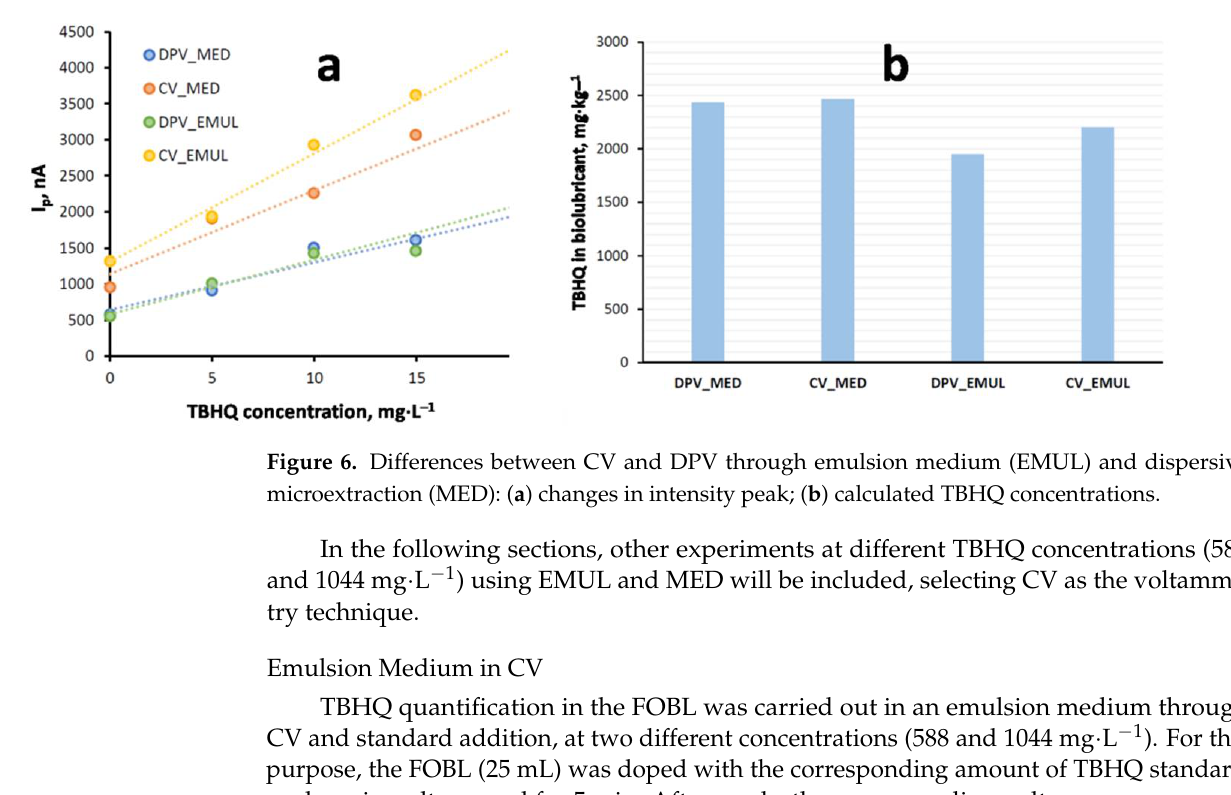
Table 4. TBHQ concentration in doped FOBL through emulsion medium (588 and 1044 mg·L −1 ) through CV.